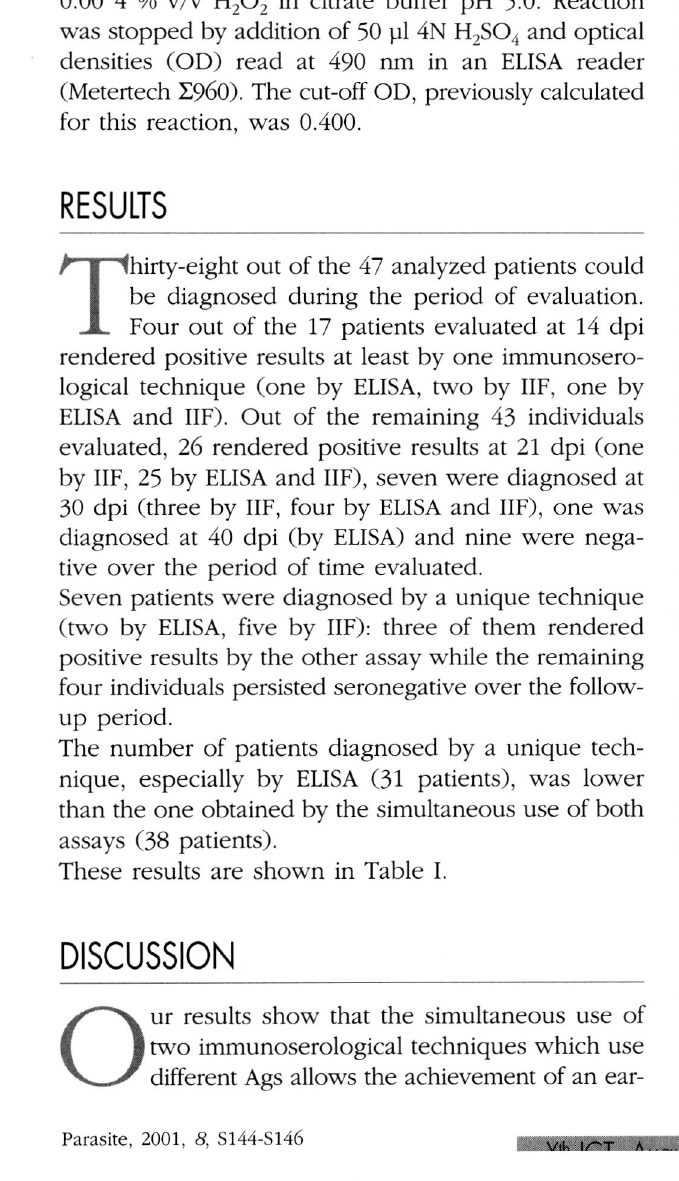
Table I. - Number of patients diagnosed by a unique and/or both immunoserological assays at different days post-ingestion.